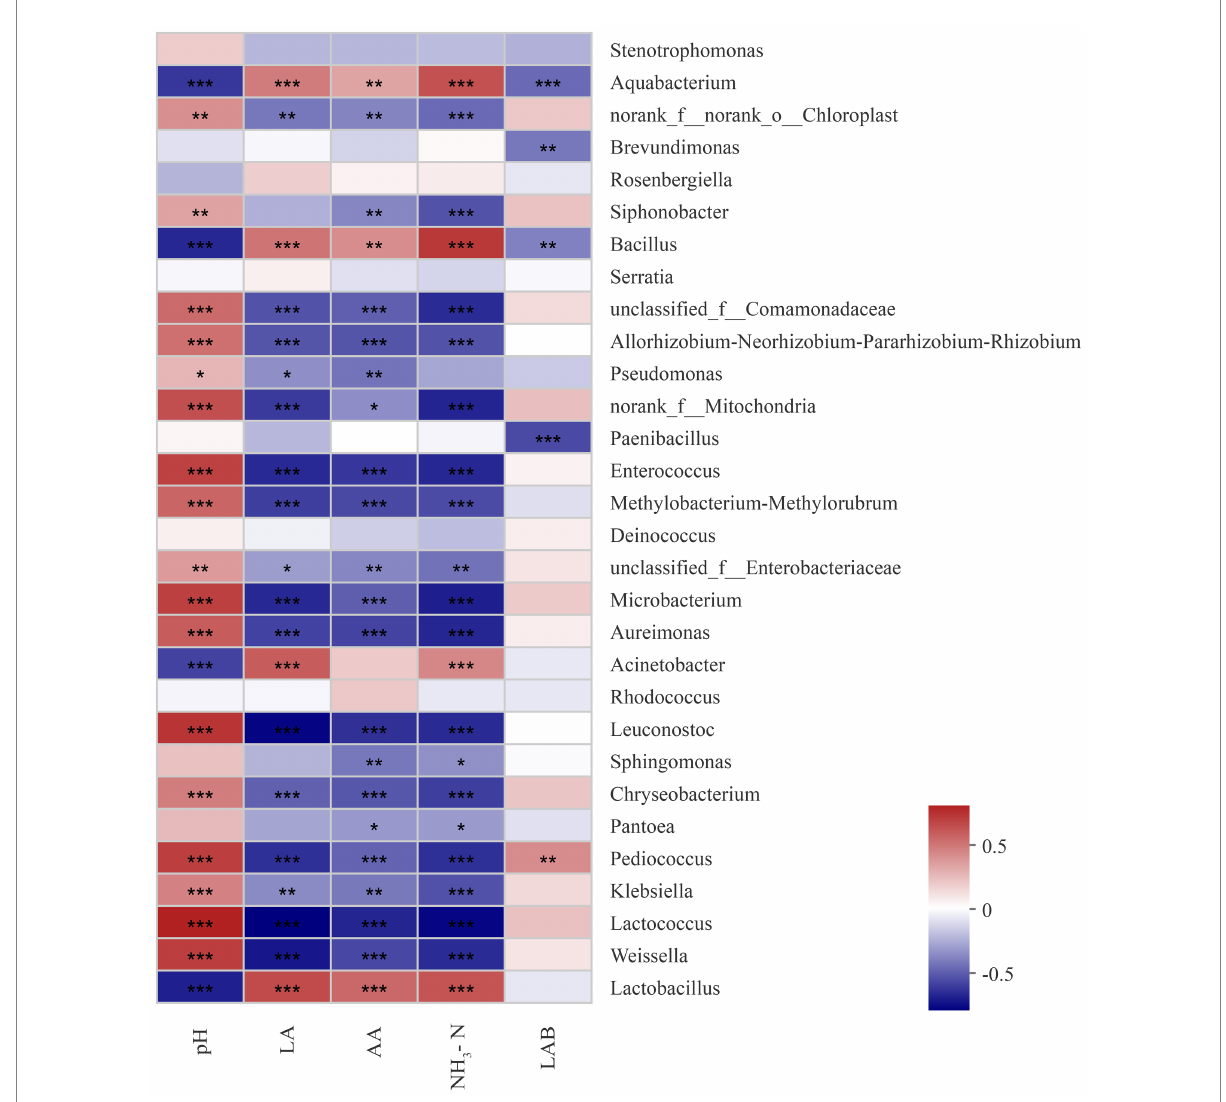
FIGURE 4 Correlation of the bacterial community and silage fermentation (LA, Lactic acid; AA, Acetic acid; NH 3 -N, ammonia nitrogen; LAB, Lactic acid bacteria; p -values are shown as *0.01 < P ≤ 0.05, **0.001 < p ≤ 0.01, *** p ≤